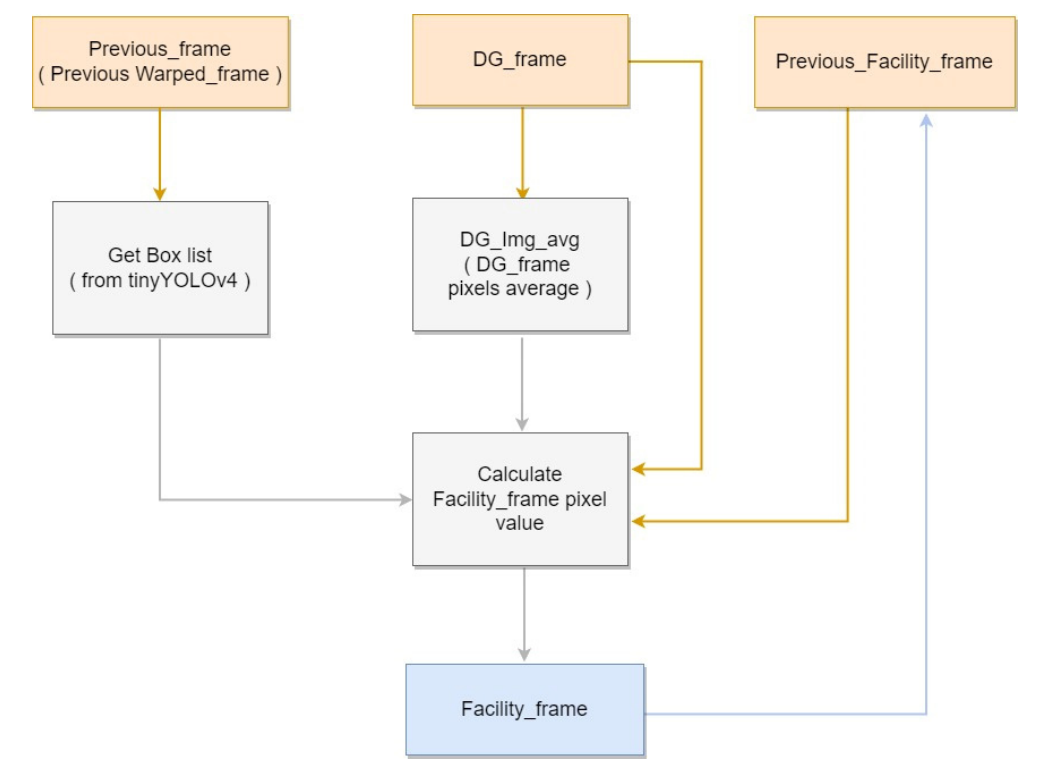
Figure 6. Facility Generation block diagram.